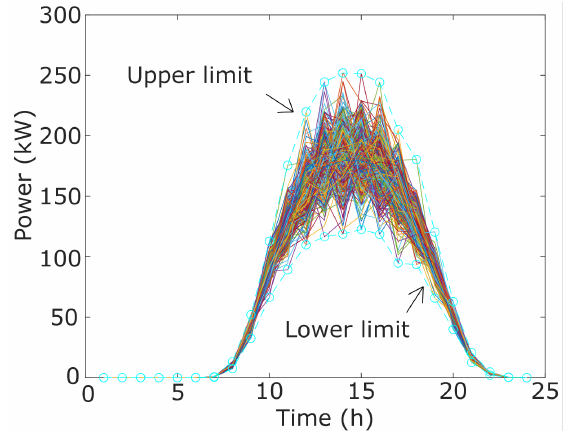
Figure 2. Residential PV generators in 24 h, data from